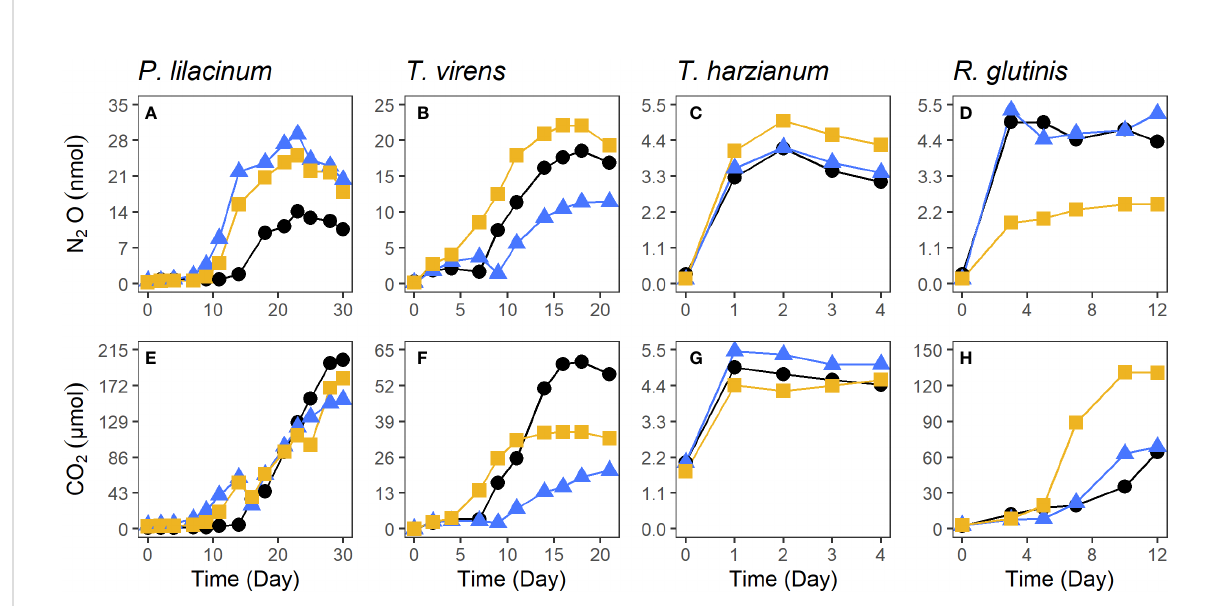
FIGURE 2 The production of N 2 O and CO 2 by P. lilacinum (A, E) , T. virens (B, F) , T. harzianum (C, G) , and R. glutinis (D, H) isolated from salt marsh sediments. Each color and symbol combination represents one of the three replicates.